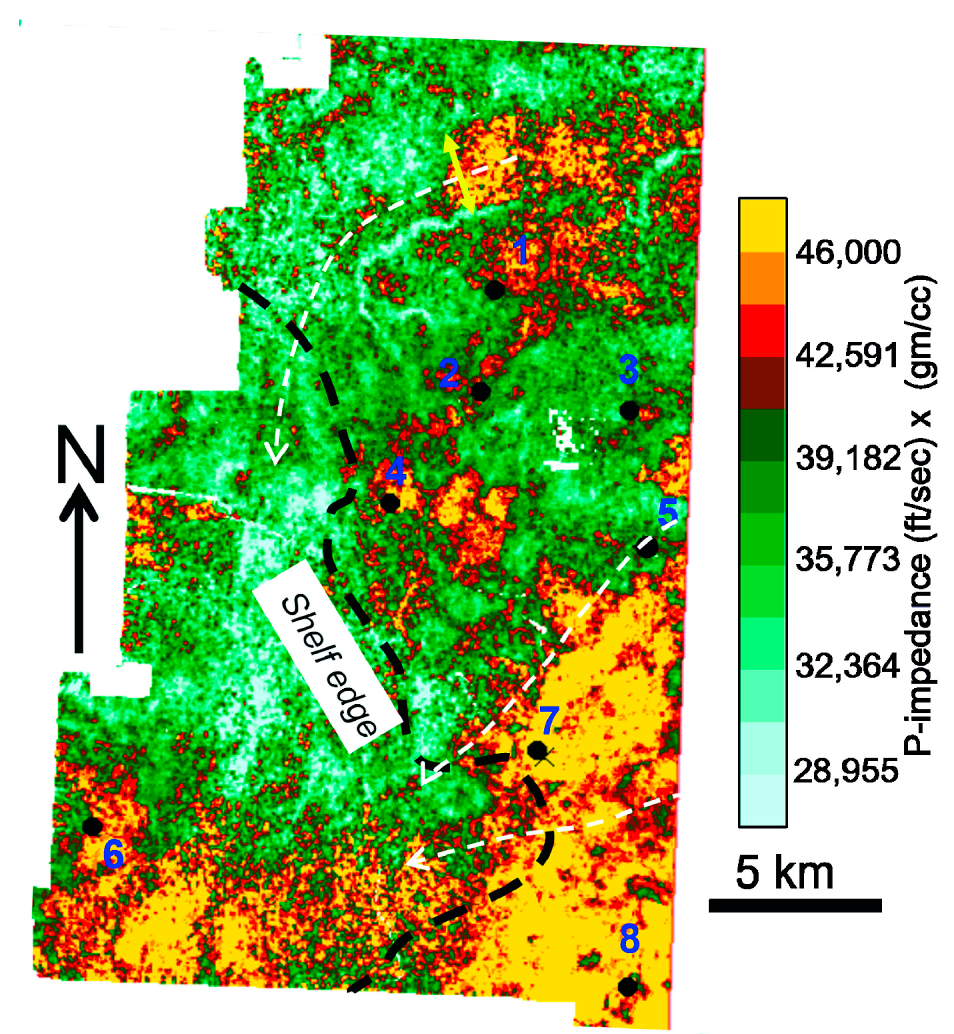
Figure 10. Inverted P-impedance map extracted at top Strawn horizon. Note: dashed black line = shelf edge, yellow-orange-red = high-impedance zones, green–light-green = moderate- to low-impedance zones, respectively. White dashed arrows indicate valley axes. Numbers (in blue) indicate well names. Yellow double-headed arrow indicates width of northernmost valley.